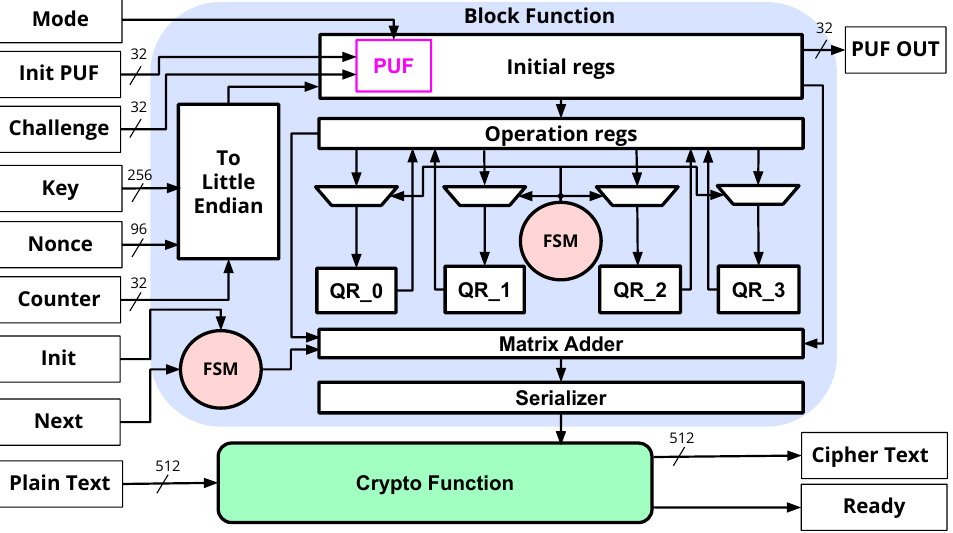
Figure 9. Architecture of the ChaCha20 crypto core